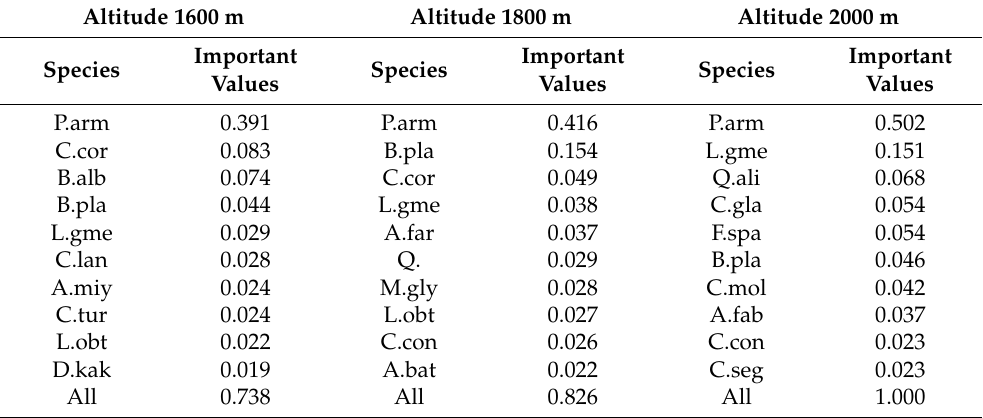
Table 8. Ranking of the top ten important values of tree species compositions at different elevations.